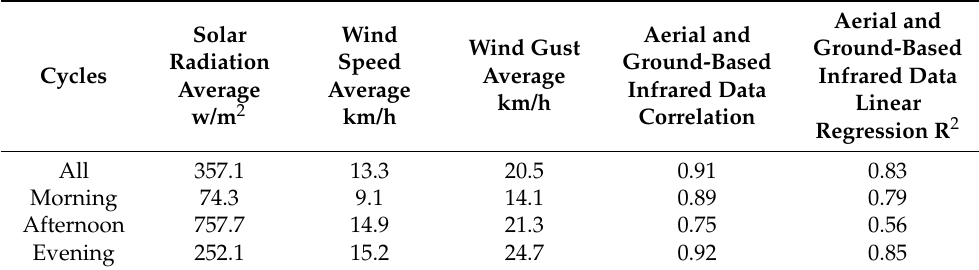
Table 7. Aerial and ground-based infrared data comparison based on different time cycles and observation context variables.